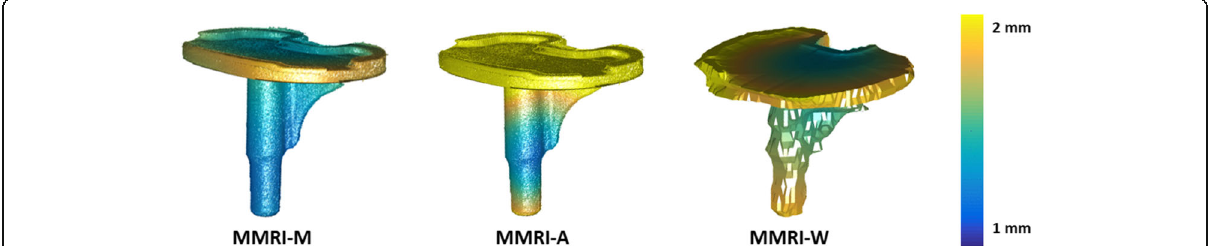
Fig. 3 Distance plots for translation of the prosthesis with respect to the bone for the three types of registration methods used. (MMRI-M, MMRI- A and